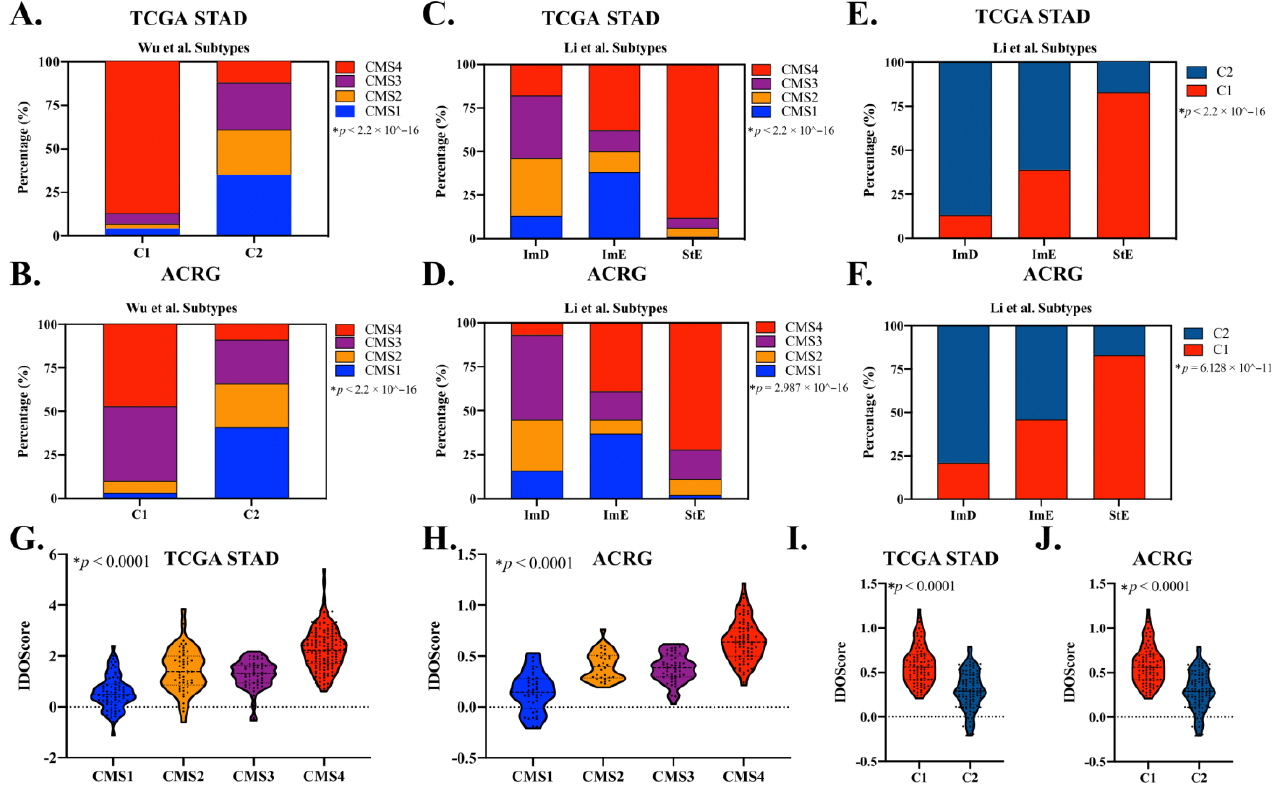
Figure 6. The CMS subtyping system has meaningful overlap with other immune signature-based classifications in GAC. ( A , B ) CMS proportion in Wu et al. molecular subtypes. Proportions of 88% and 48% of C1 subtype were represented as CMS4, whereas 35% and 41% of C2 subtypes were represented as CMS1 in TCGA-STAD ( A ) and ACRG ( B ) cohorts, respectively. ( C , D ) CMS proportion in Li et al. molecular subtypes. Proportion of 88% and 72% of StE were represented as CMS4, and 69% and 77% of ImD were represented as CMS2+CMS3 in TCGA-STAD ( C ) and ACRG ( D ) cohorts, respectively. ImE was represented as an equal proportion of CMS1 (37 – 38%) and CMS4 (38 – 39%) in both GAC cohorts. ( E , F ) Wu et al. subtype proportions among Li subtypes. A proportion of 83% of StE were represented as C1 subtype, and ImE was represented as a nearly equal portion of C1 and C2 in both TCGA-STAD ( E ) and ACRG ( F ) cohorts. Proportion of 87% and 79% of ImD were represented as C2 subtypes in TCGA-STAD and ACRG cohorts, respectively. ( G – J ). IDOScore in each subtyping system. CMS4 had the highest score, whereas CMS1 had the lowest IDOScore among all CMS subtypes both in TCGA-STAD ( G ) and ACRG ( H ) cohorts. Wu et al. C1 subtype had a higher IDOSocre than C2 subtype both in TCGA-STAD ( I ) and ACRG ( J ) cohorts. Fisher’s exact test was performed for ( A – F ), Kruskal–Wallis test was performed for ( G , H ), and Wilcoxon test was